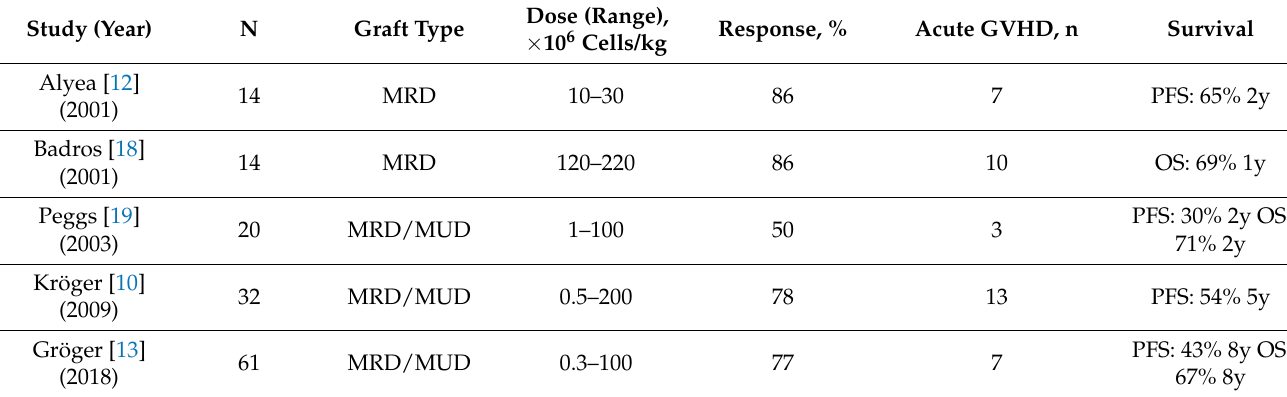
Table 1. Results of prophylactic donor lymphocyte infusion (DLI).